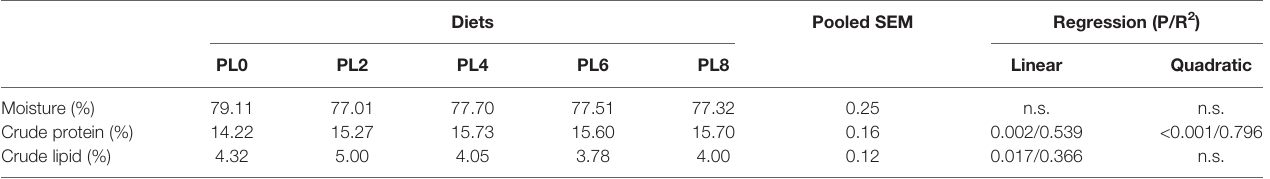
TABLE 4 | Effects of dietary phospholipids on whole body composition of largemouth bass larvae fed the experimental diets for 28 days*. Diets Pooled